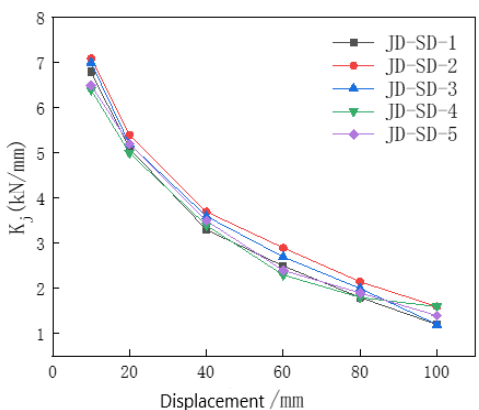
Figure 15. Stiffness degradation coefficient of S series joints varying with displacement.